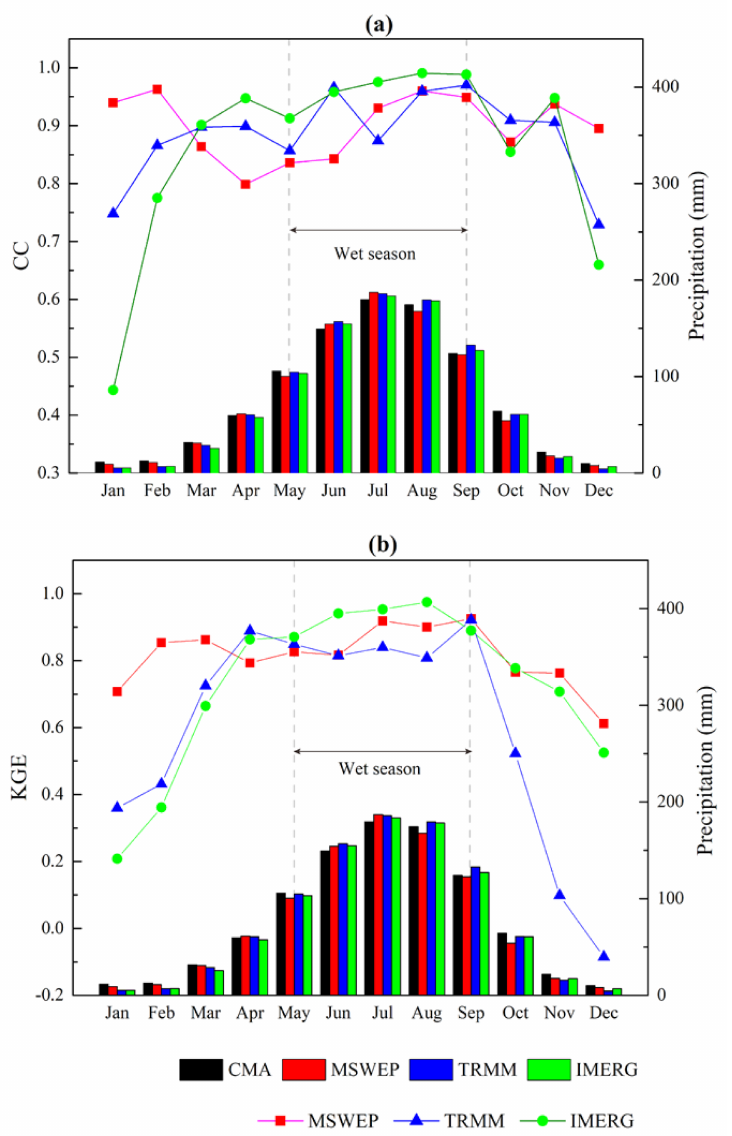
Figure 7. Distribution of ( a ) CC and ( b ) KGE values of monthly average precipitation over 16 years, along with mean monthly rainfall for each precipitation